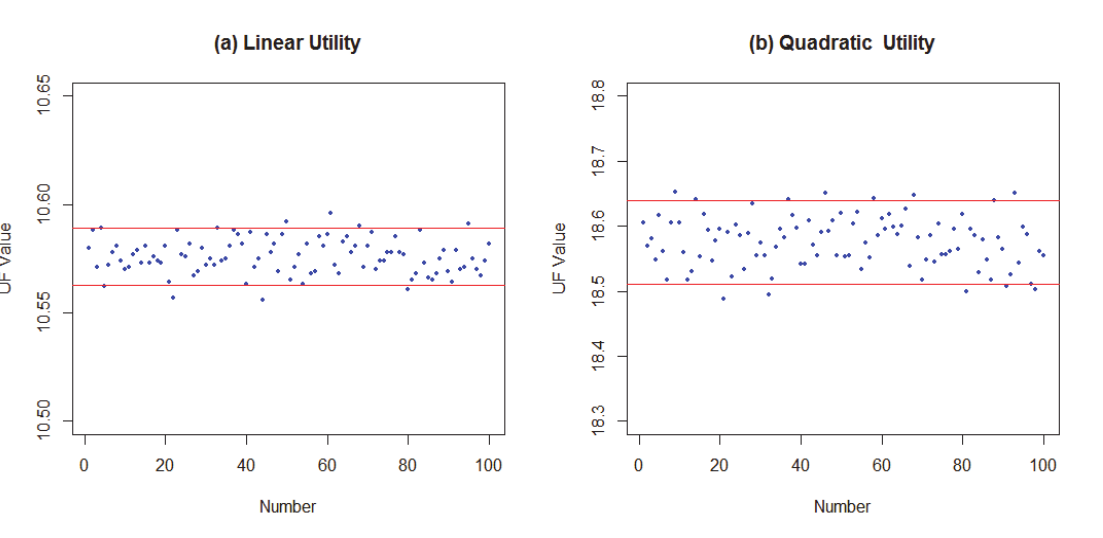
Fig. 1. Test for simulation